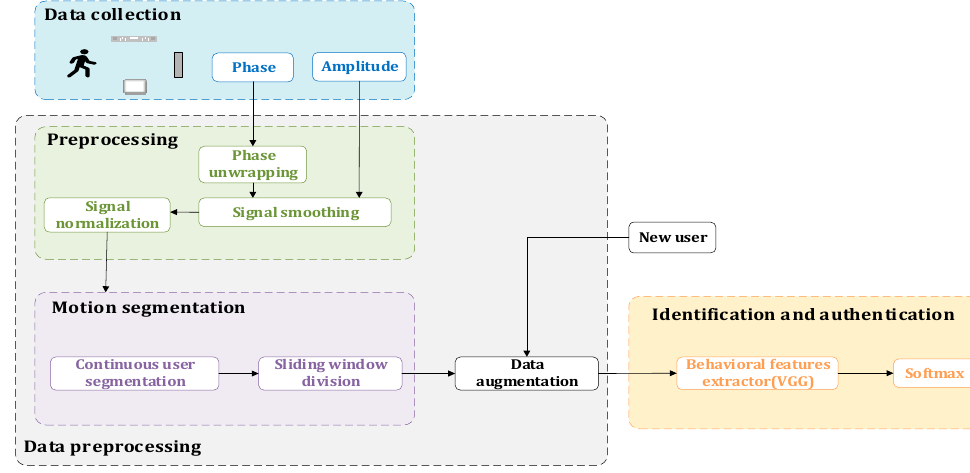
Figure 5. RF-Detection System.